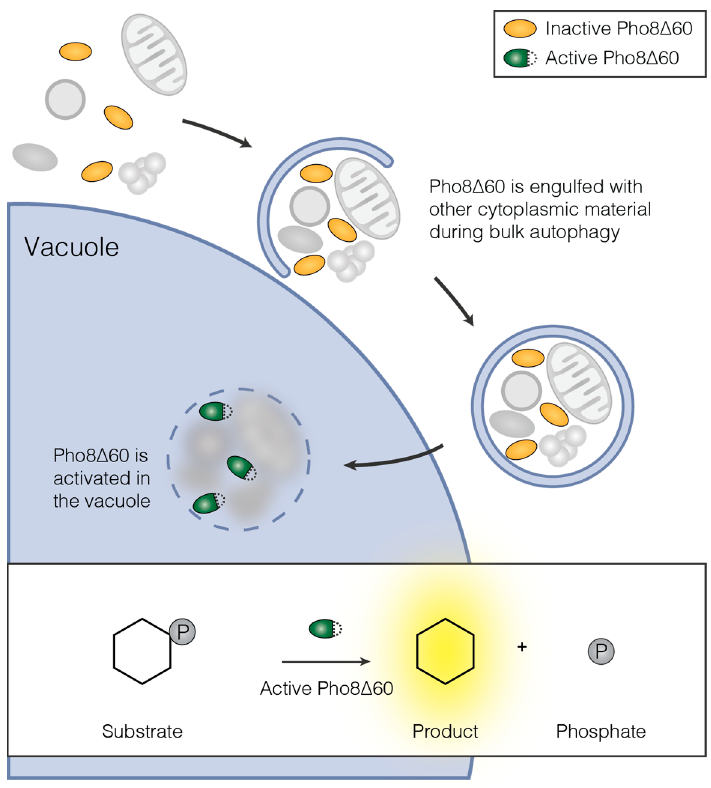
Figure 2. Principle of the Pho8 ∆ 60 assay for measuring bulk autophagic flux. The inactive precursor of Pho8 ∆ 60 is randomly sequestered in bulk autophagosomes together with cytoplasmic material. Upon delivery to the vacuole, Pho8 ∆ 60 is proteolytically activated. Insert: The activity of Pho8 ∆ 60 is measured in cell lysate by supplying a phosphatase substrate. Depending on the substrate, dephosphorylation by Pho8 ∆ 60 yields products, which can be detected either spectrophotometrically or spectrofluorometrically—see text for details.